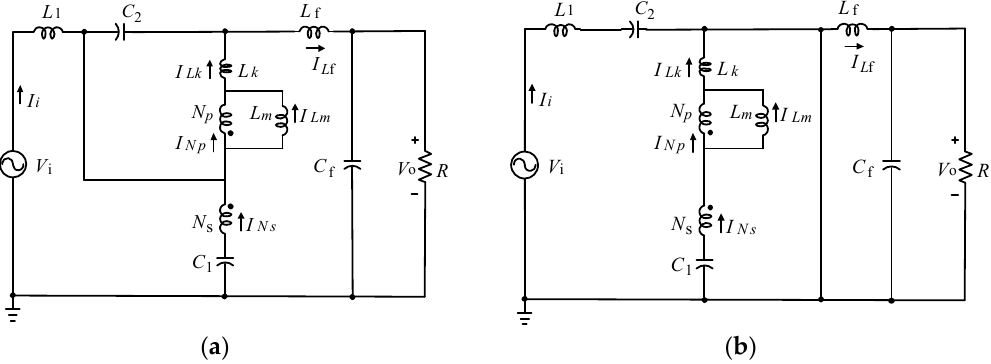
Figure 7. Equivalent circuits of the suggested topology: ( a ) NST state and ( b ) ST state.